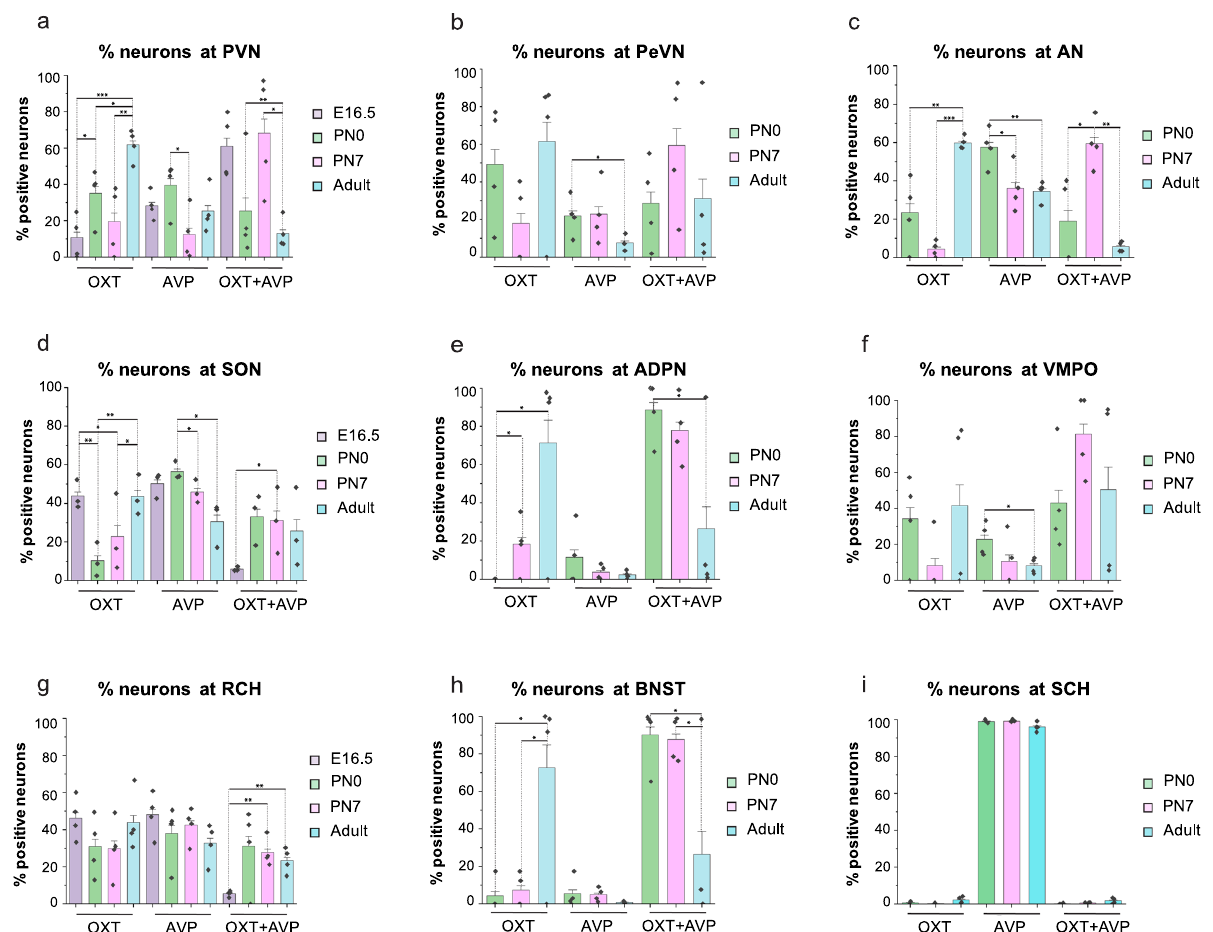
Fig. 5 Quanti fi cation of OXT and AVP neurons during development. Percentage of OXT, AVP and OXT + AVP neurons is represented at E16.5, PN0, PN7, and adult brain. OXT and AVP co-labeling peaks at PN7 and then decreases in favor of OXT expression in most nuclei with the exception of SCH which is primarily constituted by AVP-expressing neurons ( a – i ). Data are represented as mean ± S.E.M ( n = 4) and data points are included on each graph. T-Student test, p -value % OXT: PVN = 0.041; PVN = 0.00043; PVN = 0.02003; PVN = 0.00640; SON E16.5-PN0 E16.5-Adult PN0-Adult PN7-Adult E16.5-PN0